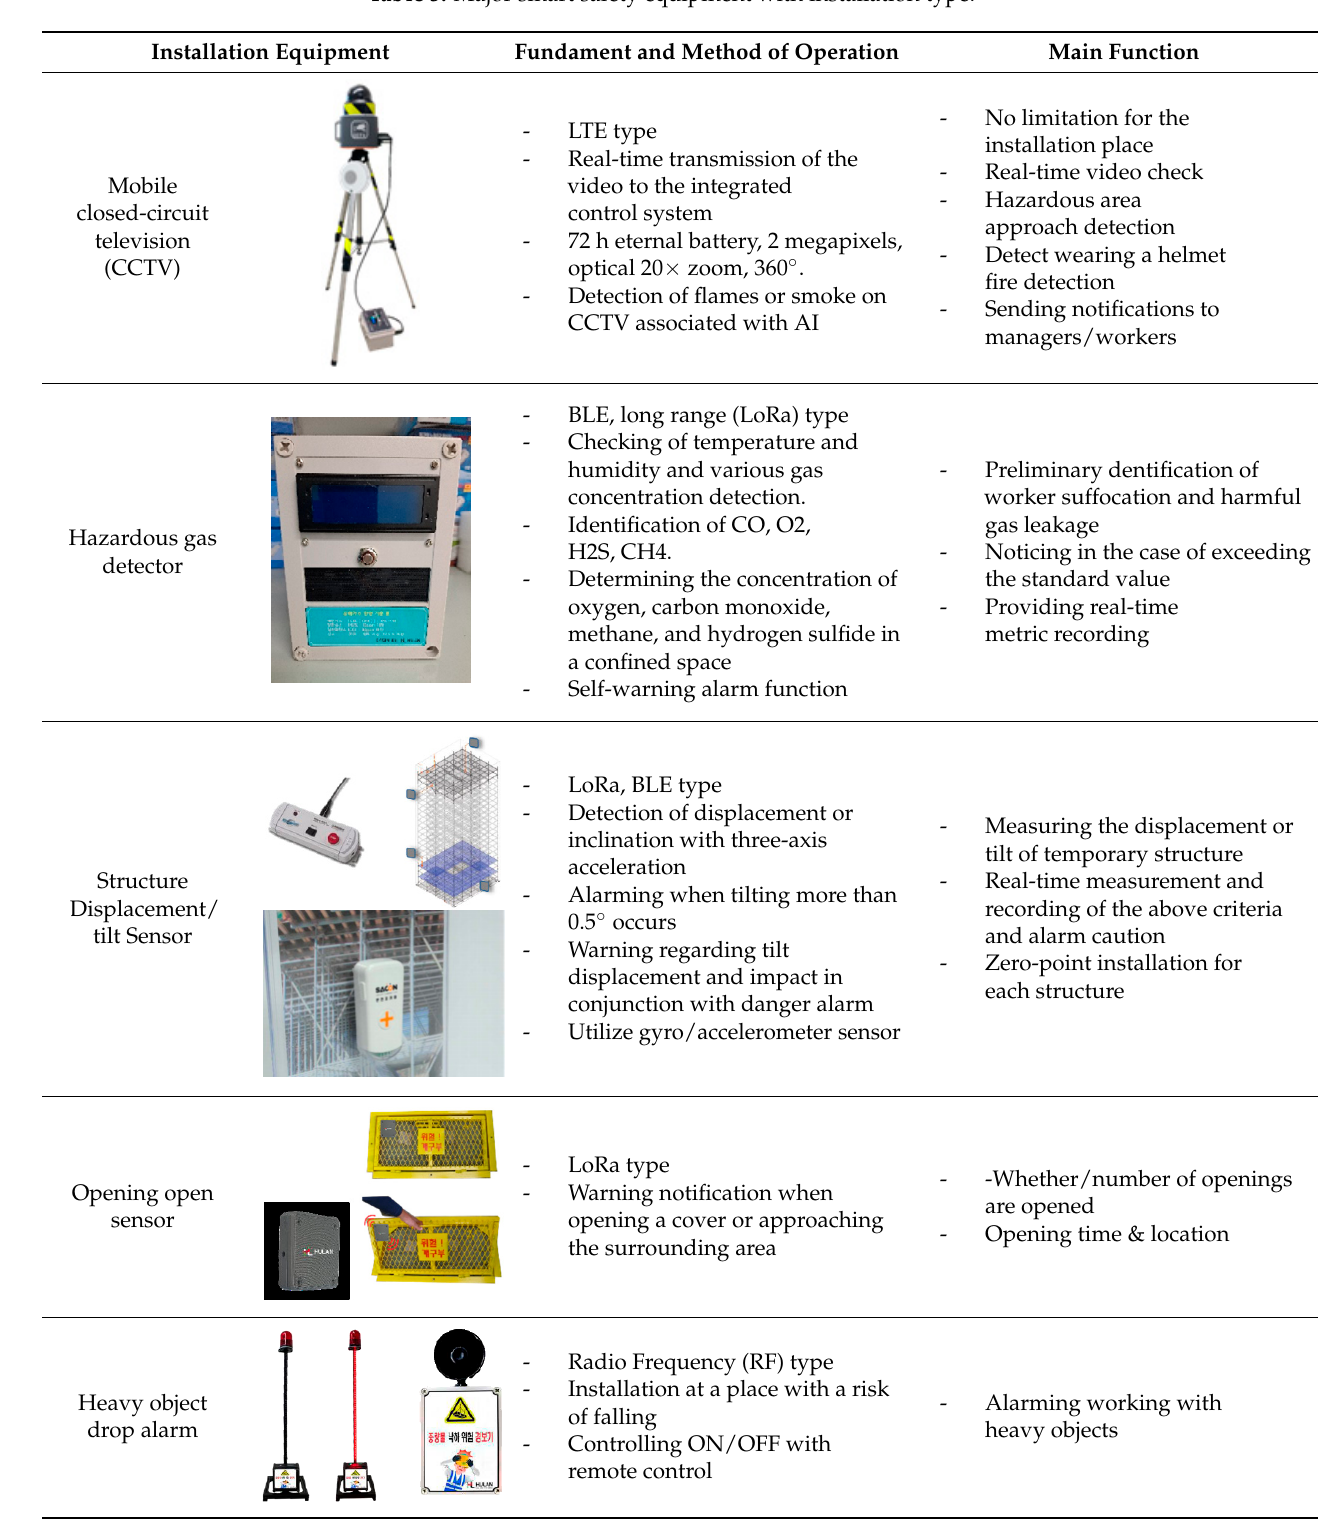
Table 3. Major smart safety equipment with installation type.